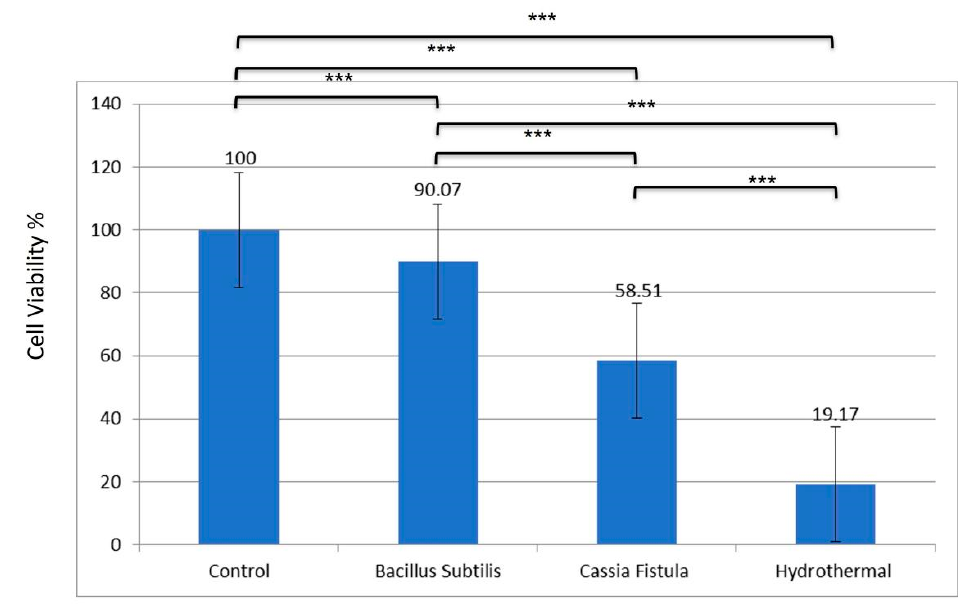
Figure 13. Cell Viability (%) of titanium nanoparticles formed by Bacillus subtilis , Cassia fistula and